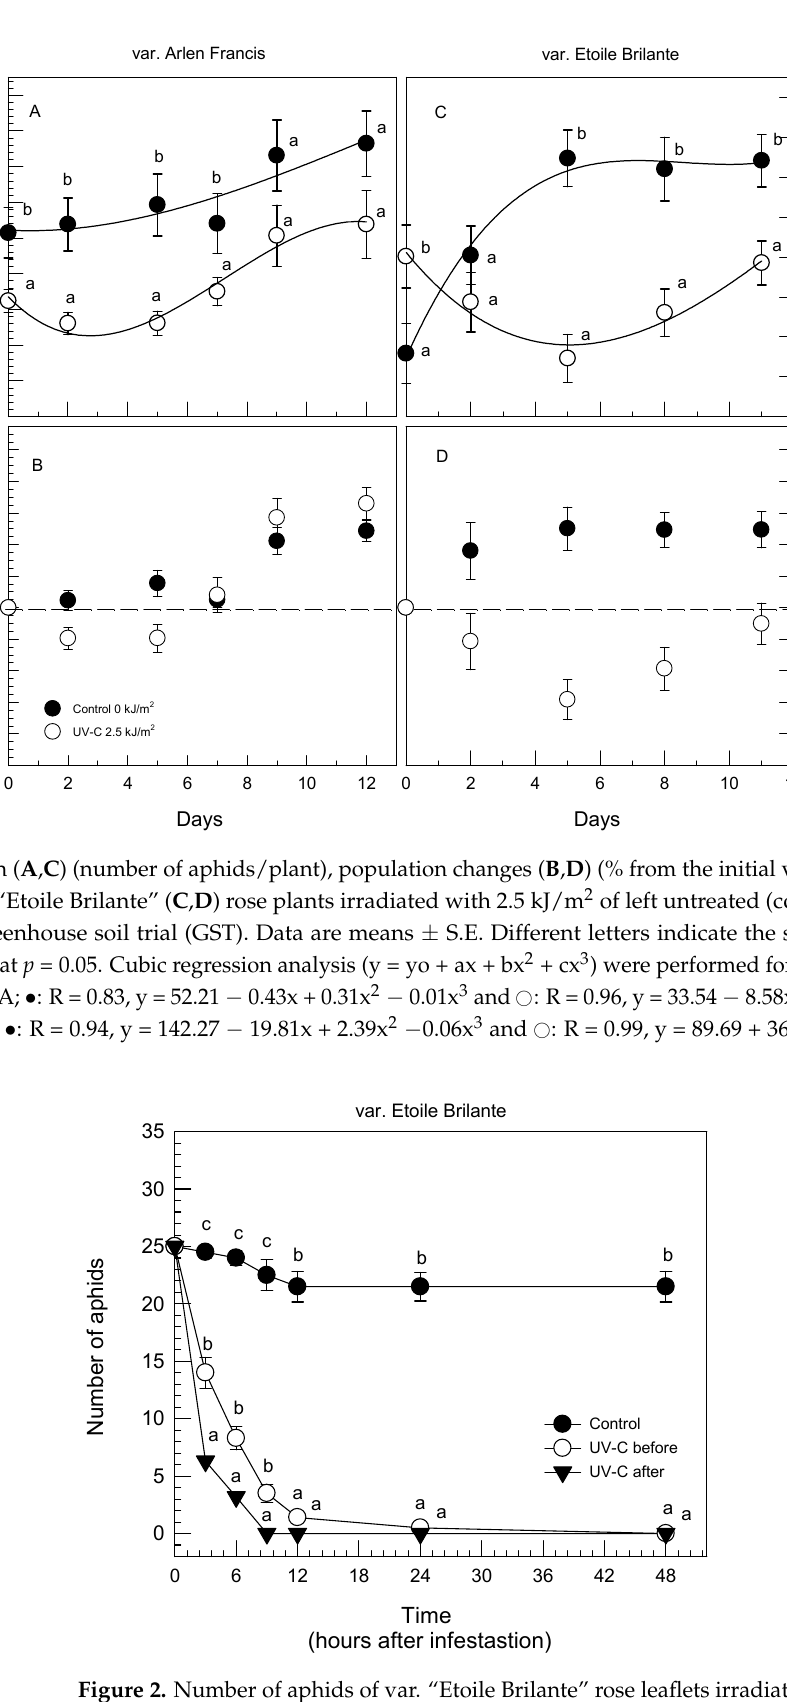
Figure 2. Number of aphids of var. “Etoile Brilante” rose leaflets irradiated with 2.5 kJ/m 2 before or after infestation during GPT. Untreated plants were used as controls. Data are means ± S.E. Different letters indicate significant differences between treatments at p = 0.05.